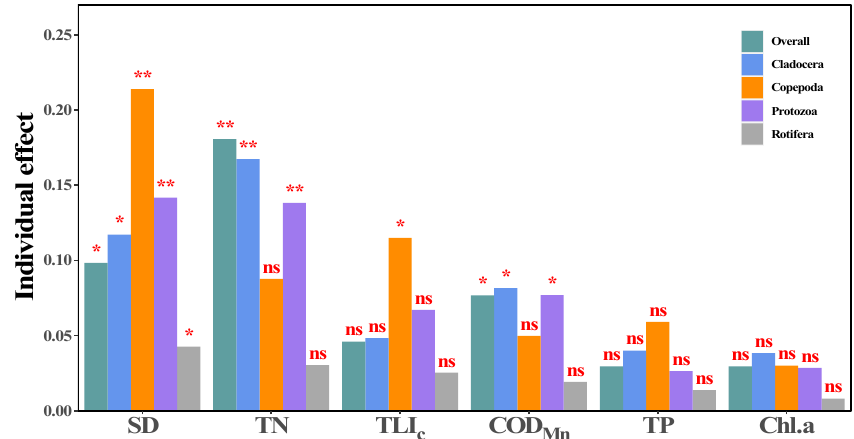
Figure 8. The individual effects of environmental factors on zooplankton composition. The histo- gram shows the results of hierarchical partitioning for the variables’ explanation rate in the overall analysis (based on the presence/absence data of all the taxa) and separate analysis (based on the abundance data of each taxonomic group). **: p < 0.01, *: p < 0.05, ns: not significant. SD: Secchi disk depth, Chl. a : chlorophyll a , TN: total nitrogen, TP: total phosphorus, COD Mn : permanganate index, HR: Hanjiang reservoir area, DR: Danjiang reservoir area, BD: the area close to the dam. Mantel’s test showed that SD correlated significantly with most of the zooplankton functional groups, followed by TN and COD Mn ( p < 0.05, Figure 9). Moreover, significant correlations of the LCF group with Chl. a and TP were revealed ( p < 0.05), which was not detected in the aforementioned analyses.